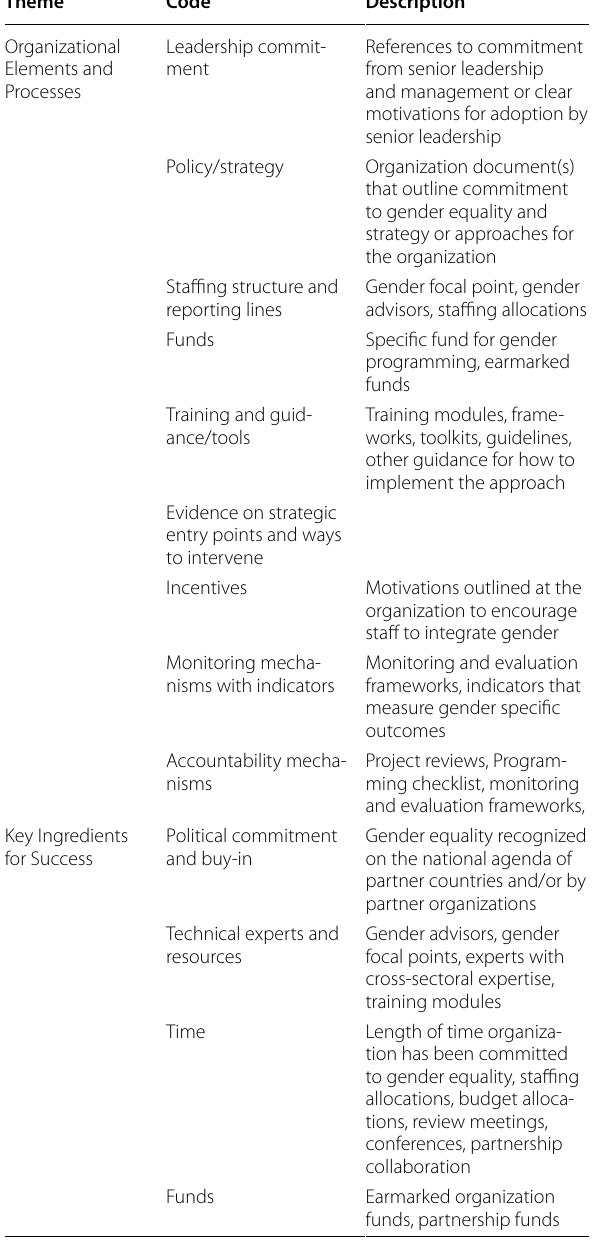
Table 6 Analytical Framework for Analyzing Key